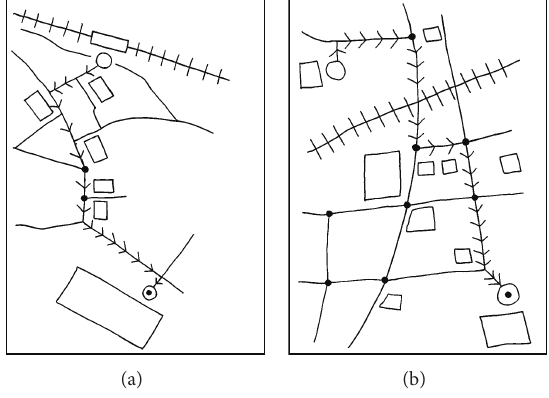
Figure 2: Examples for hand-drawn maps.